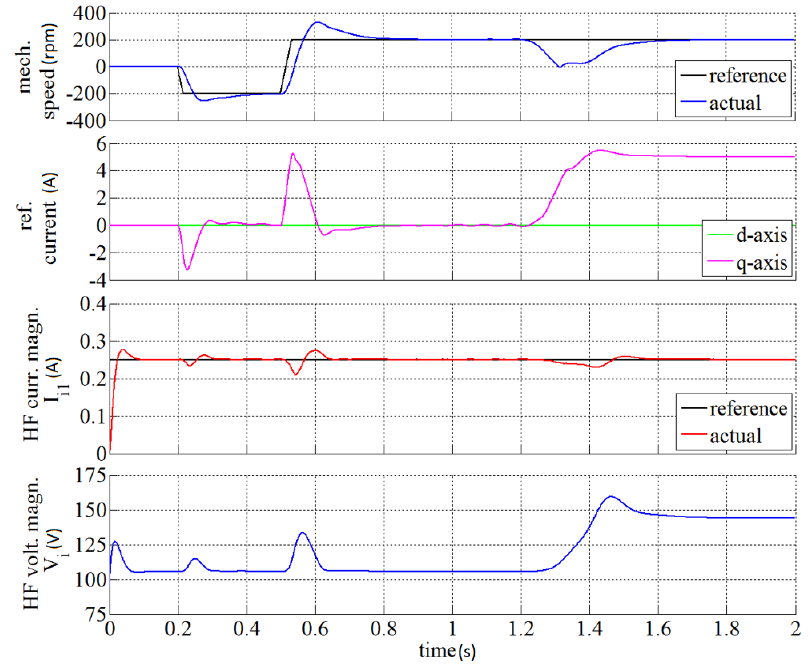
Figure 8. Simulated High-Frequency (HF) anisotropy signal magnitude regulation during speed start-up and transients (reference, control start-up and transients (reference, load).